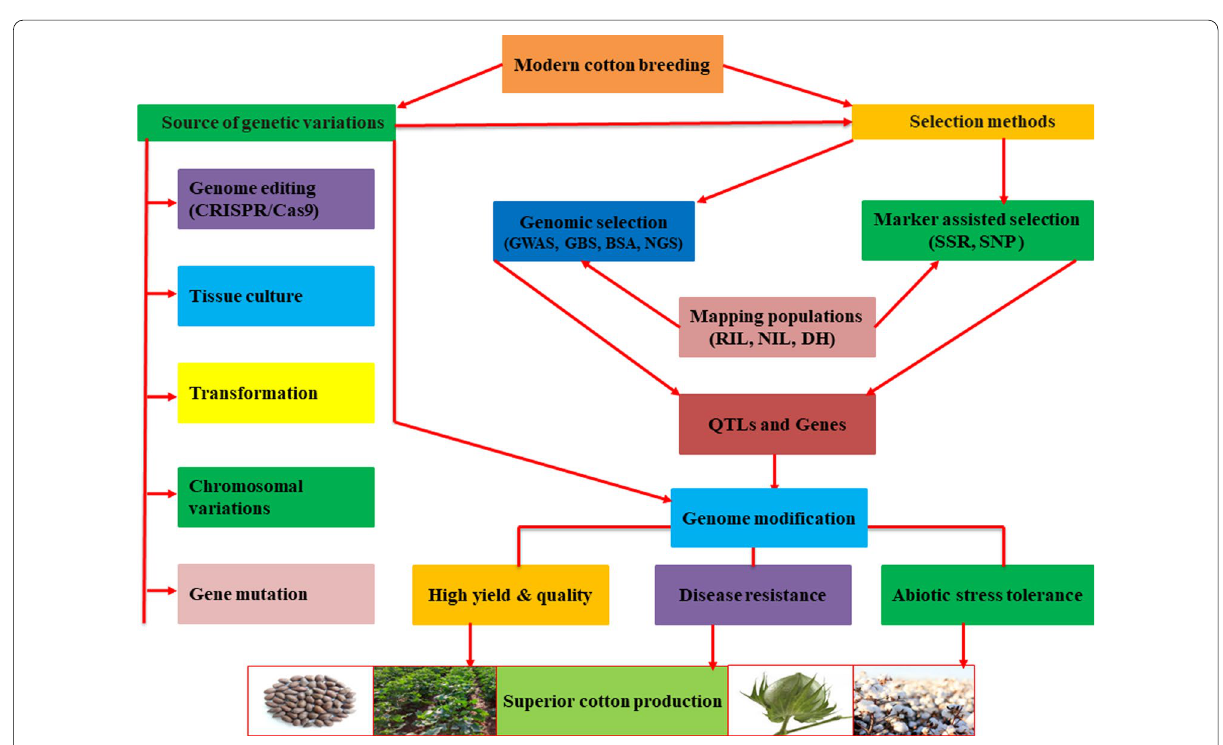
Fig. 5 The overall scheme of modern breeding measures to produce superior